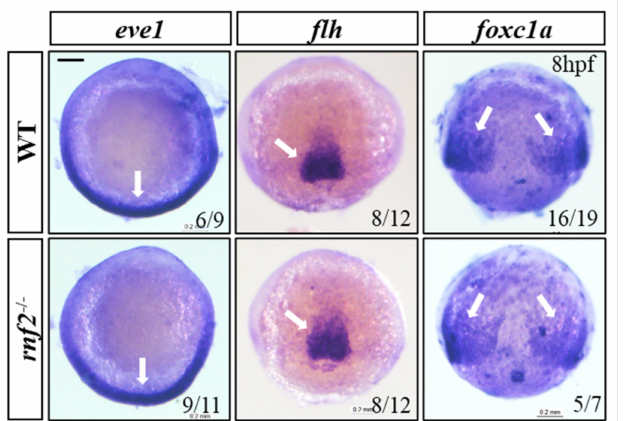
Figure 3. The mesoderm formed normally in Rnf2-null zebrafish embryos. WISH results showing expression of mesoderm markers eve1 (ventral mesoderm), flh (axial mesoderm), and foxc1a (paraxial mesoderm). The expression regions are indicated by white arrows. Scale bar: 0.2